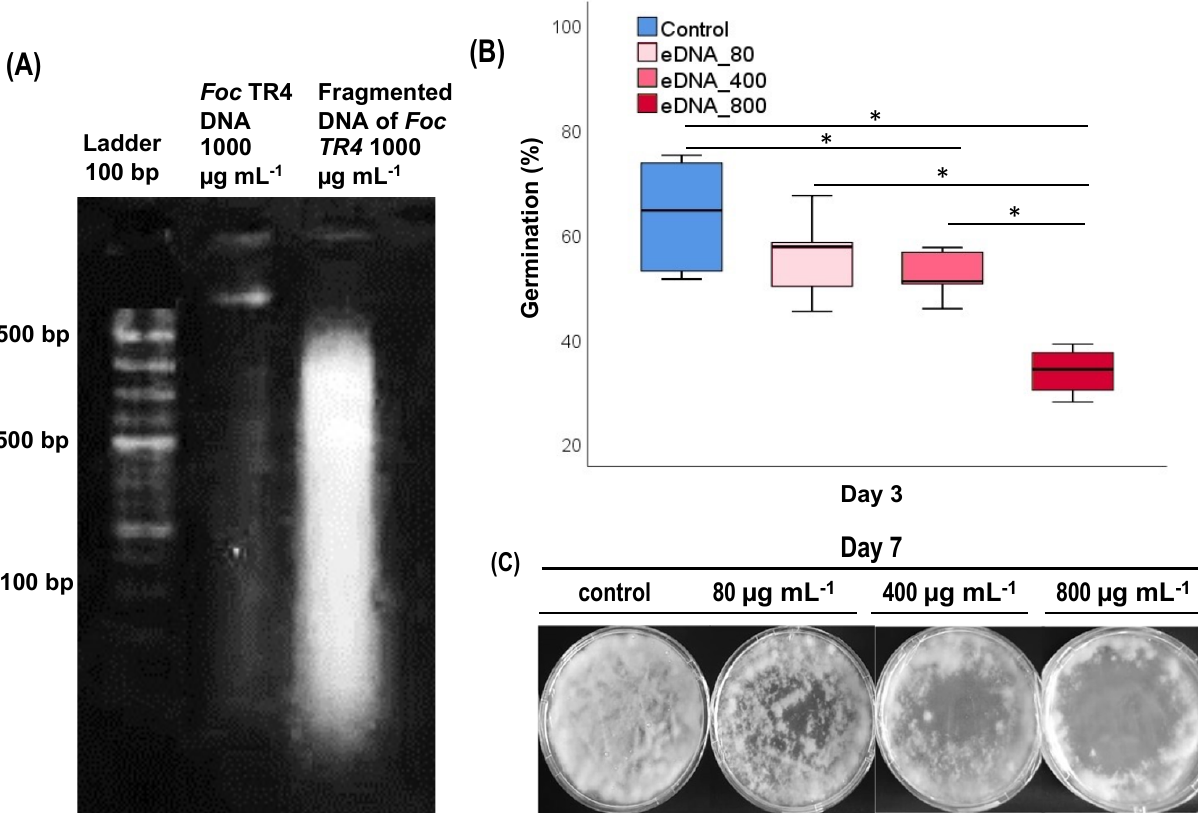
Figure 1. Self-inhibition test of Fusarium oxysporum (Foc) TR4. ( A ) Intact genomic and fragmented eDNA of Foc TR4, ( B ) quantification of Foc TR4 germination rate on day 3 post-inoculation, ( C ) limited mycelium growth of Foc TR4 upon culturing on PDA medium with the respective treatment of eDNA on day 7 post-inoculation. ANOVA test results showed a p -value < 0.05. Duncan’s test results are indicated by the asterisk and line on top of the boxes of the box plot.